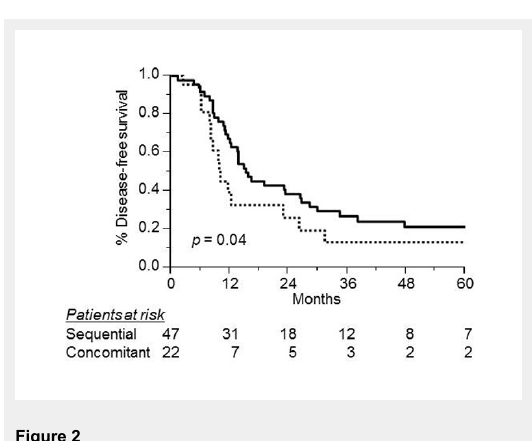
Disease-free survival according to sequential (solid line, n = 47) versus concomitant (dotted line, n = 22) chemotherapy in 69 patients with limited stage small-cell lung cancer (log rank test, p = 0.02).